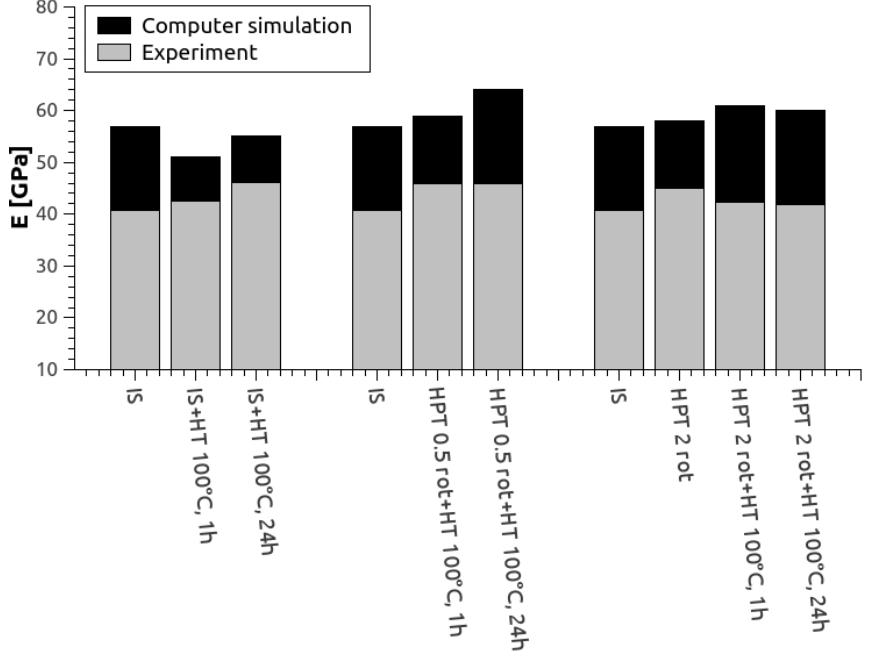
Figure 15. Comparison of measured and simulated values of Young’s modulus data obtained from microhardness measurements and texture evaluations for Mg5Zn0.3Ca.